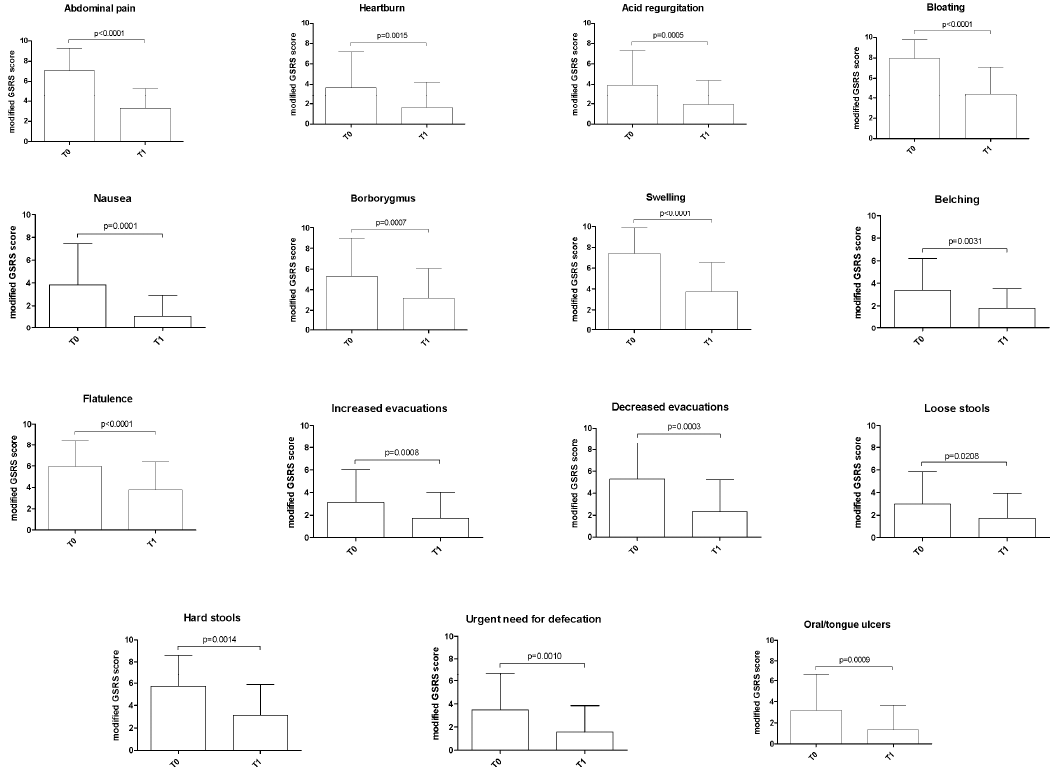
Figure 3. Variation of gastrointestinal symptoms after three months of low-nickel diet in women with endometriosis. The p-value was calculated using the Wilcoxon signed-rank test. Legend: GSRS , Gastrointestinal Symptom Rating Scale; T0 , baseline; T1 , after three months of low-nickel diet. All seven extra-intestinal symptoms showed a statistically significant reduction at T1 ( p < 0.05). Finally, all gynecological symptoms analyzed showed a significant improvement at T1 compared to T0 ( p < 0.005) (Figure 4).